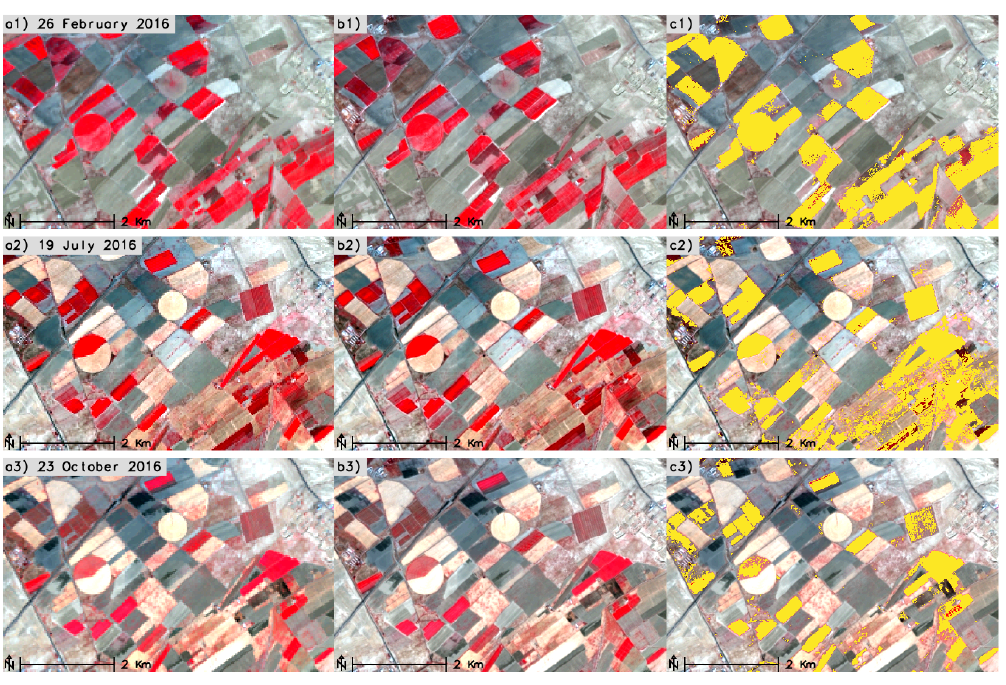
Figure 7. ( a ) Shows the False Color Composite(FCC) from spectral bands in 30 m; ( b ) shows the FCC in 15 m; and ( c ) shows the extracted irrigated area in 15 m for the respective